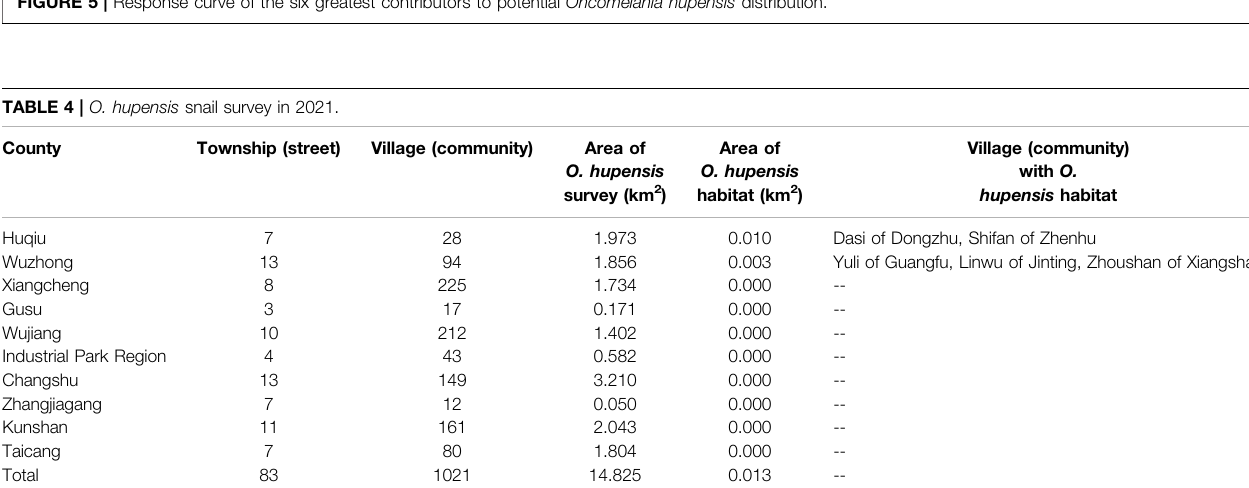
FIGURE 5 | Response curve of the six greatest contributors to potential Oncomelania hupensis distribution.